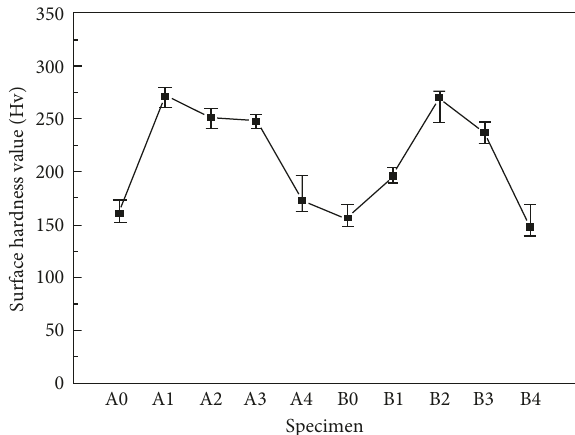
Figure 9: Surface hardness curves by deposition